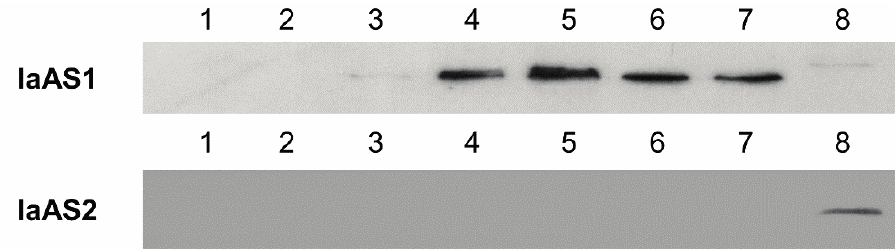
Figure 3. Western blot analysis of IaAS1 and IaAS2 expression in yeast